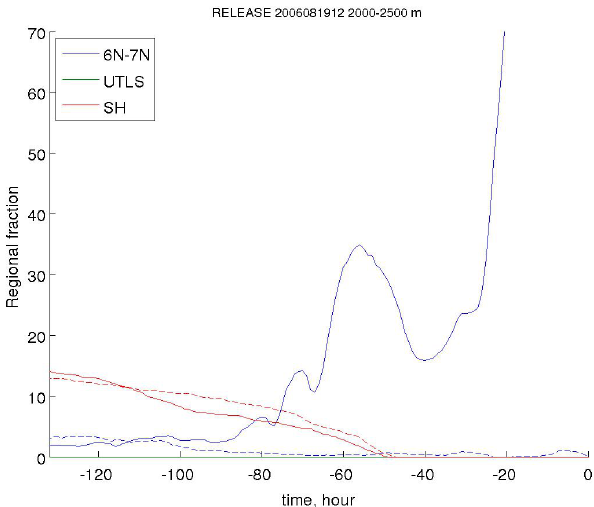
Fig. 6. Fraction of particles being in 3 different regions (see text for the definition of the regions) at each time step of backward FLEXPART runs for 2 releases above Cotonou in the altitude range 2.0-2.5 km (solid line) and 3.5-4.0 km (dotted line). The UTLS fraction ( > 8 km) is always negligible.